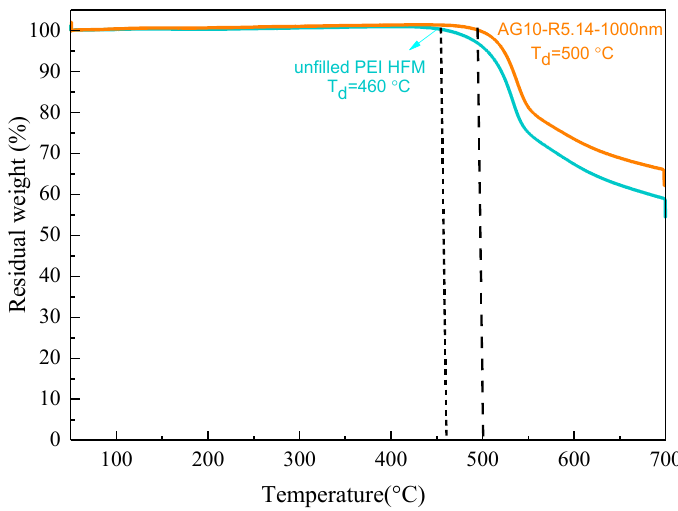
Figure 7. TGA profile of hollow fiber membrane spun at the same parameters with/without the incorporation of alumina filler.